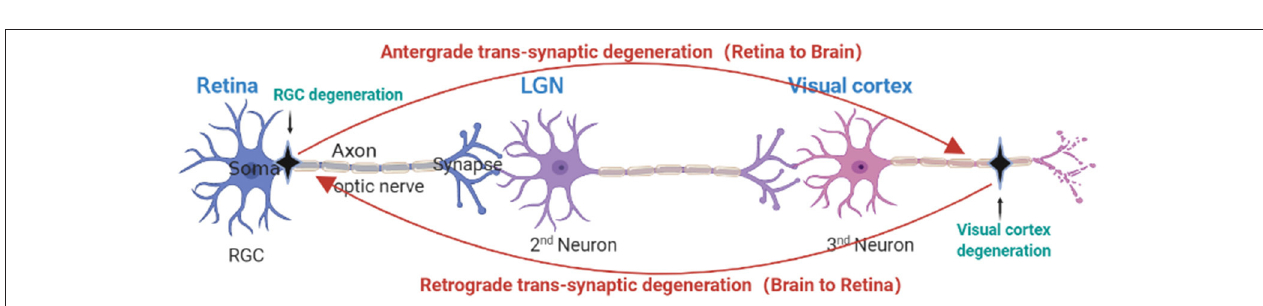
FIGURE 3 | Anatomical depiction of retrograde and anterograde transsynaptic degeneration in the visual pathway. Retrograde trans-synaptic degeneration describes the process by which damage to the posterior visual pathway (black) results in subsequent retinal degeneration. Anterograde trans-synaptic degeneration describes the process by which retinal degeneration leads to subsequent degeneration of the posterior visual